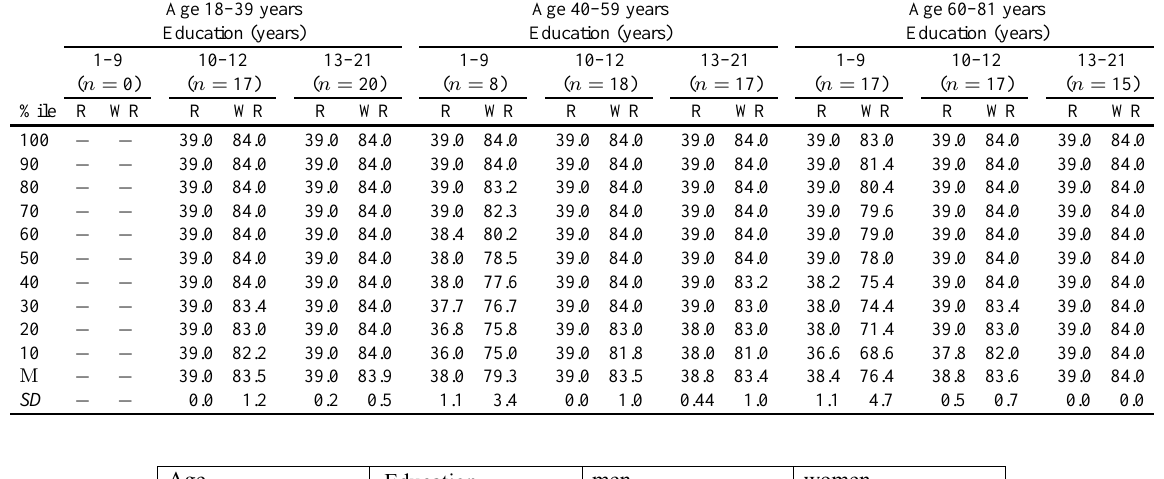
Table 6 Normative data for reading (R) and writing (WR) stratified by age and education